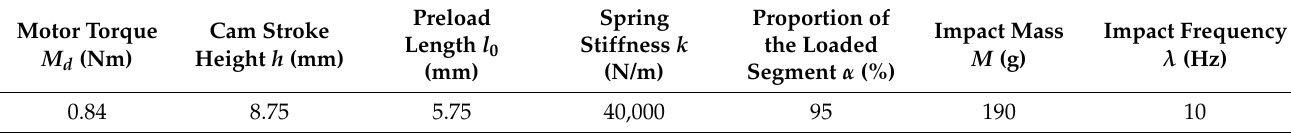
Table 2. Structural parameters of the optimized impact module.